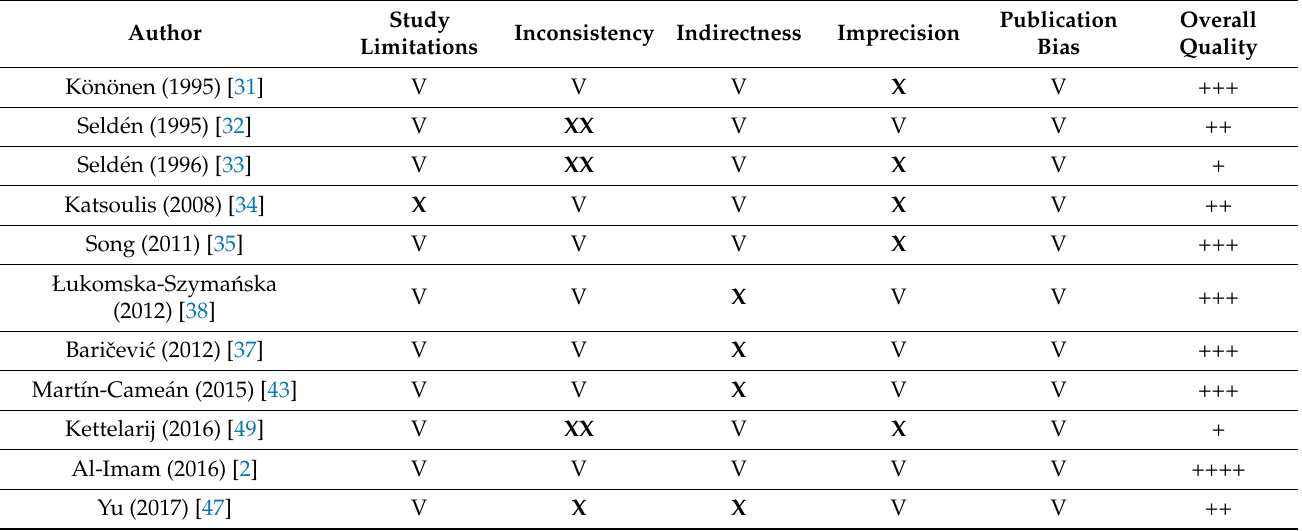
Table 2. GRADE assessment for in vivo studies. Overall quality: ++++ high, +++ moderate, ++ low, + very